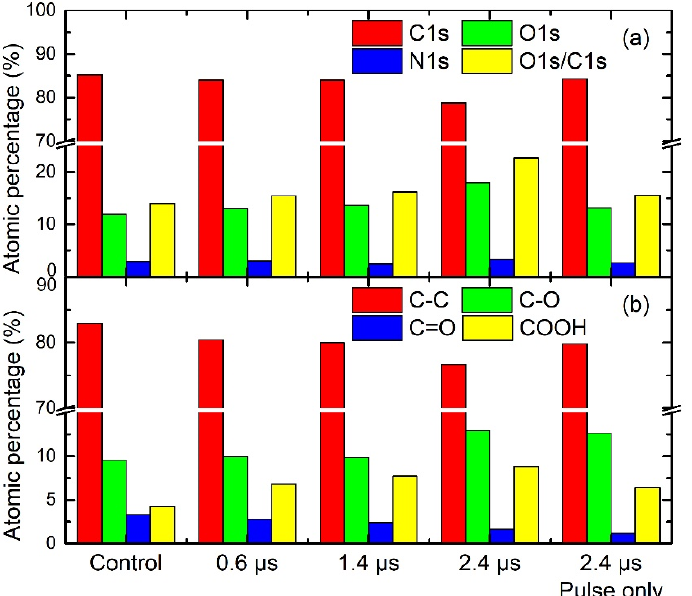
Figure 6. ( a ) Surface element analysis of untreated and different plasma-treated carbon fibers; ( b ) relative areas (%) of peaks obtained from the deconvolution of C1s peaks.